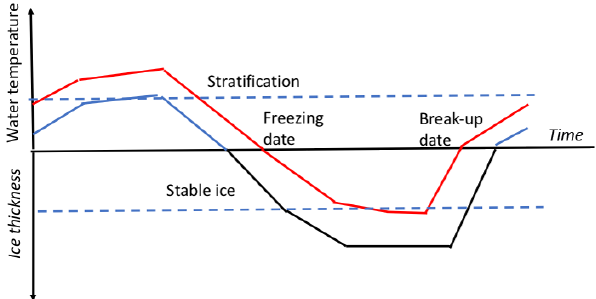
Figure 14. The annual cycle of boreal and tundra lake surface tem- peratures and ice thicknesses. The blue–black lines show a reference state with the red line illustrating climate warming impact. Ice and open water seasons change their length, including the presence of winter stable ice cover and/or summer